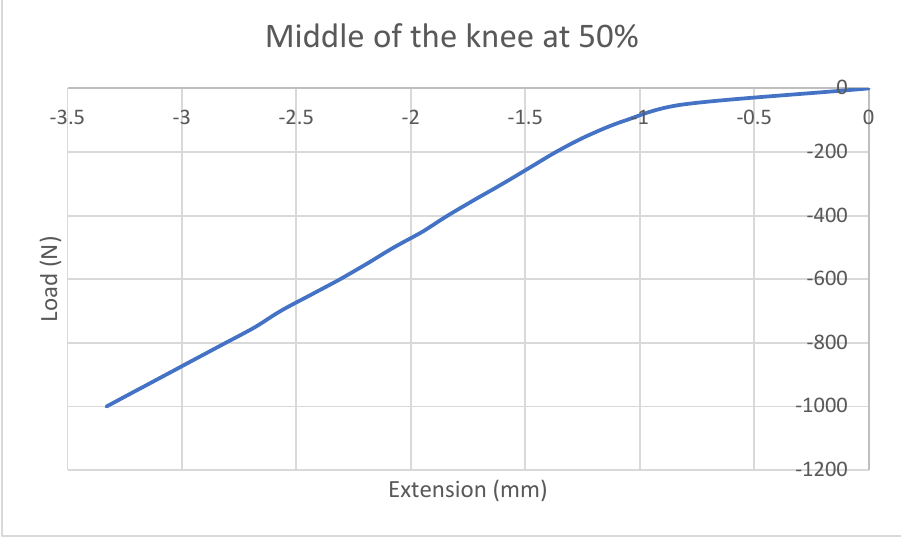
Figure 7. Variation of the force relative to the displacement—medial loading.